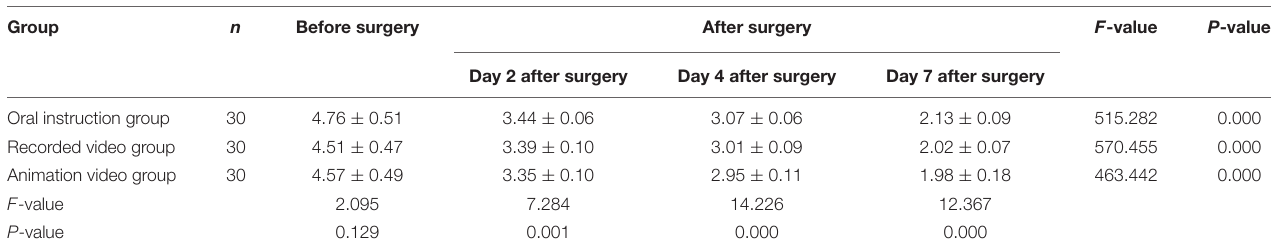
TABLE 7 | Pain levels in the three groups.